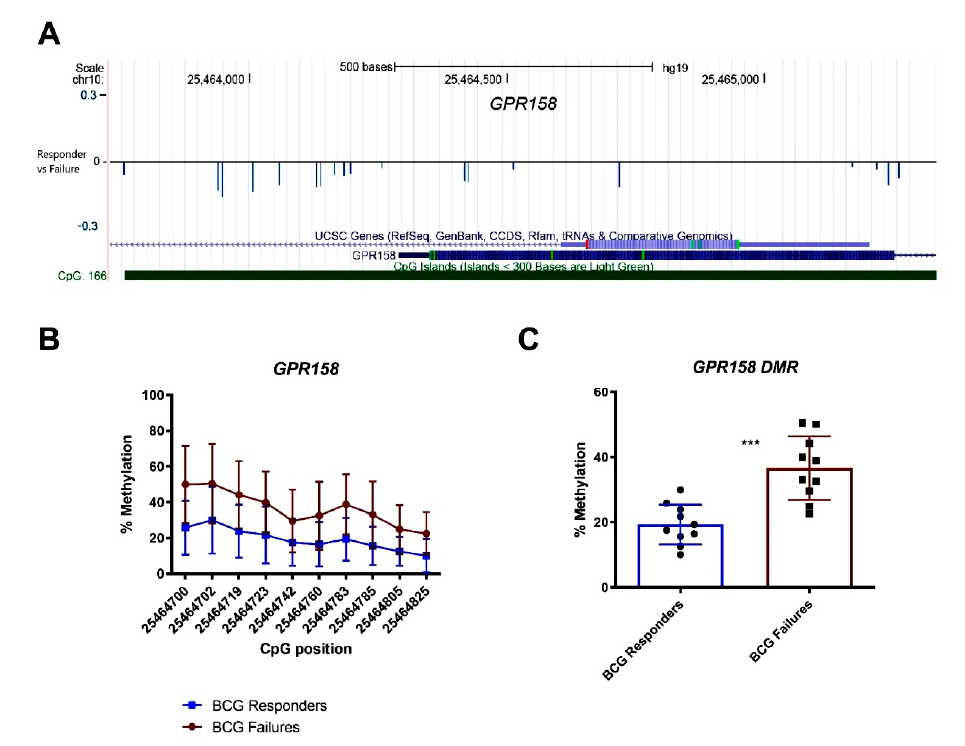
Figure 3. DMR in GPR158 gene promoter as example for di ff erential methylation between BCG responders and failures. ( A ) Graphical representation of the DMR located in the GPR158 promoter. ( B ) Bisulfite sequencing (BSP) results of single CpGs within in the GPR158 promoter shown as percentage of methylation and ( C ) comparison of overall DNA methylation percentage di ff erences of DMR in GRP158 promoter between cohorts (blue BCG responders, red BCG failures).***: p -value < 0.001.